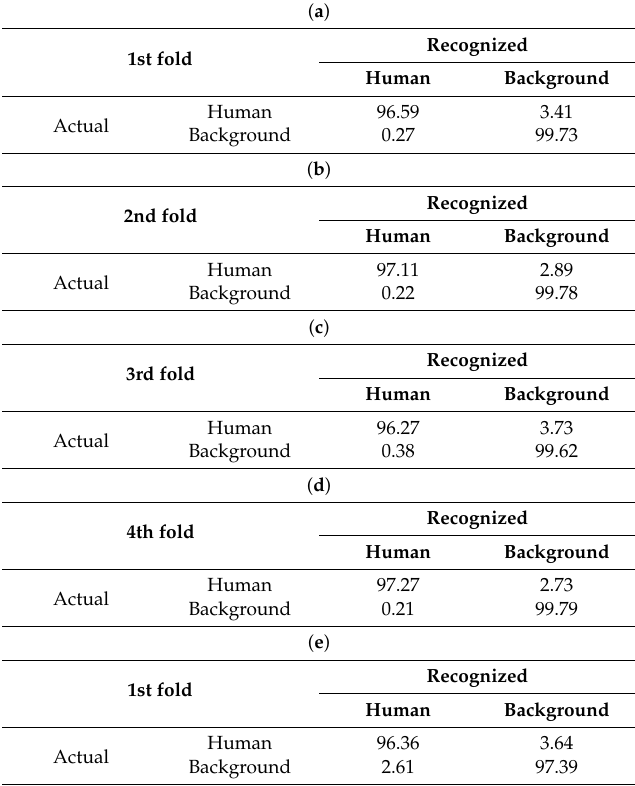
Table 4. Confusion matrix of recognition accuracies with original images by four-fold cross